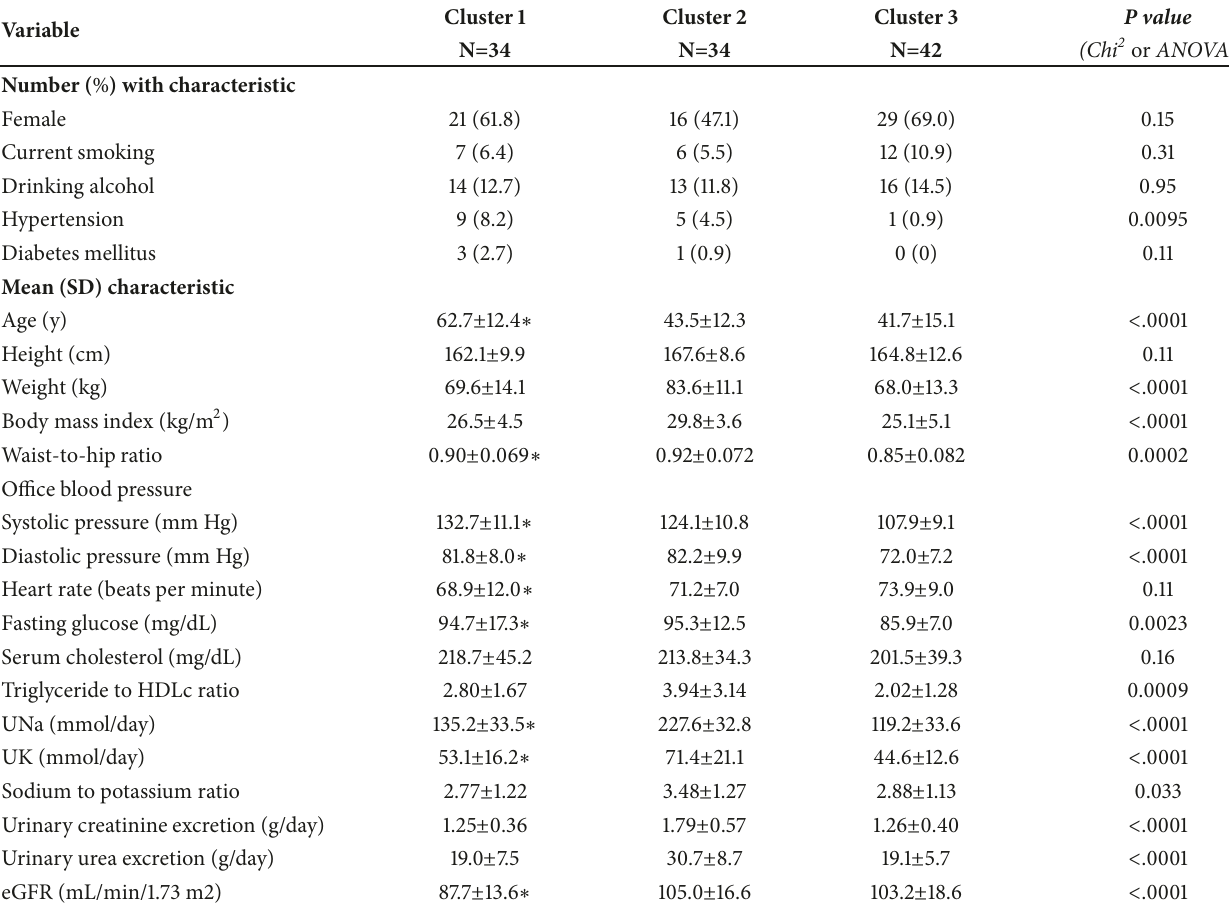
Table 4: Characteristics of participants (n=110) by